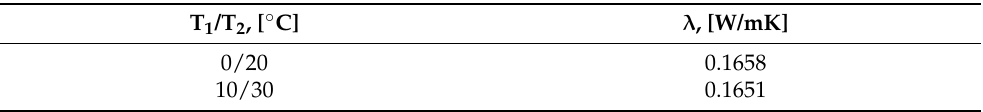
Table 1. Thermal conductivity coefficients of Micronal ® PCM SmartBoard™ 23 plasterboard in two temperature ranges: from 0 to 20 ◦ C and from 10 to 30 ◦